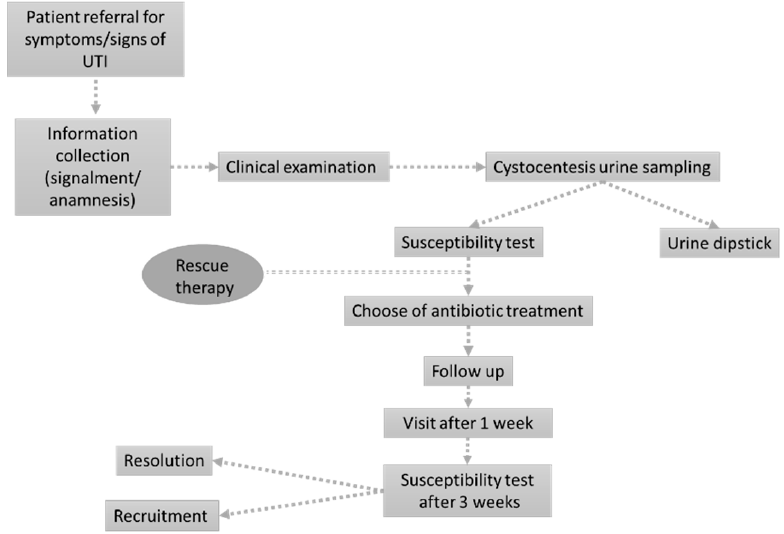
Figure 4. The figure represents the working flow specifically designed for the present study.